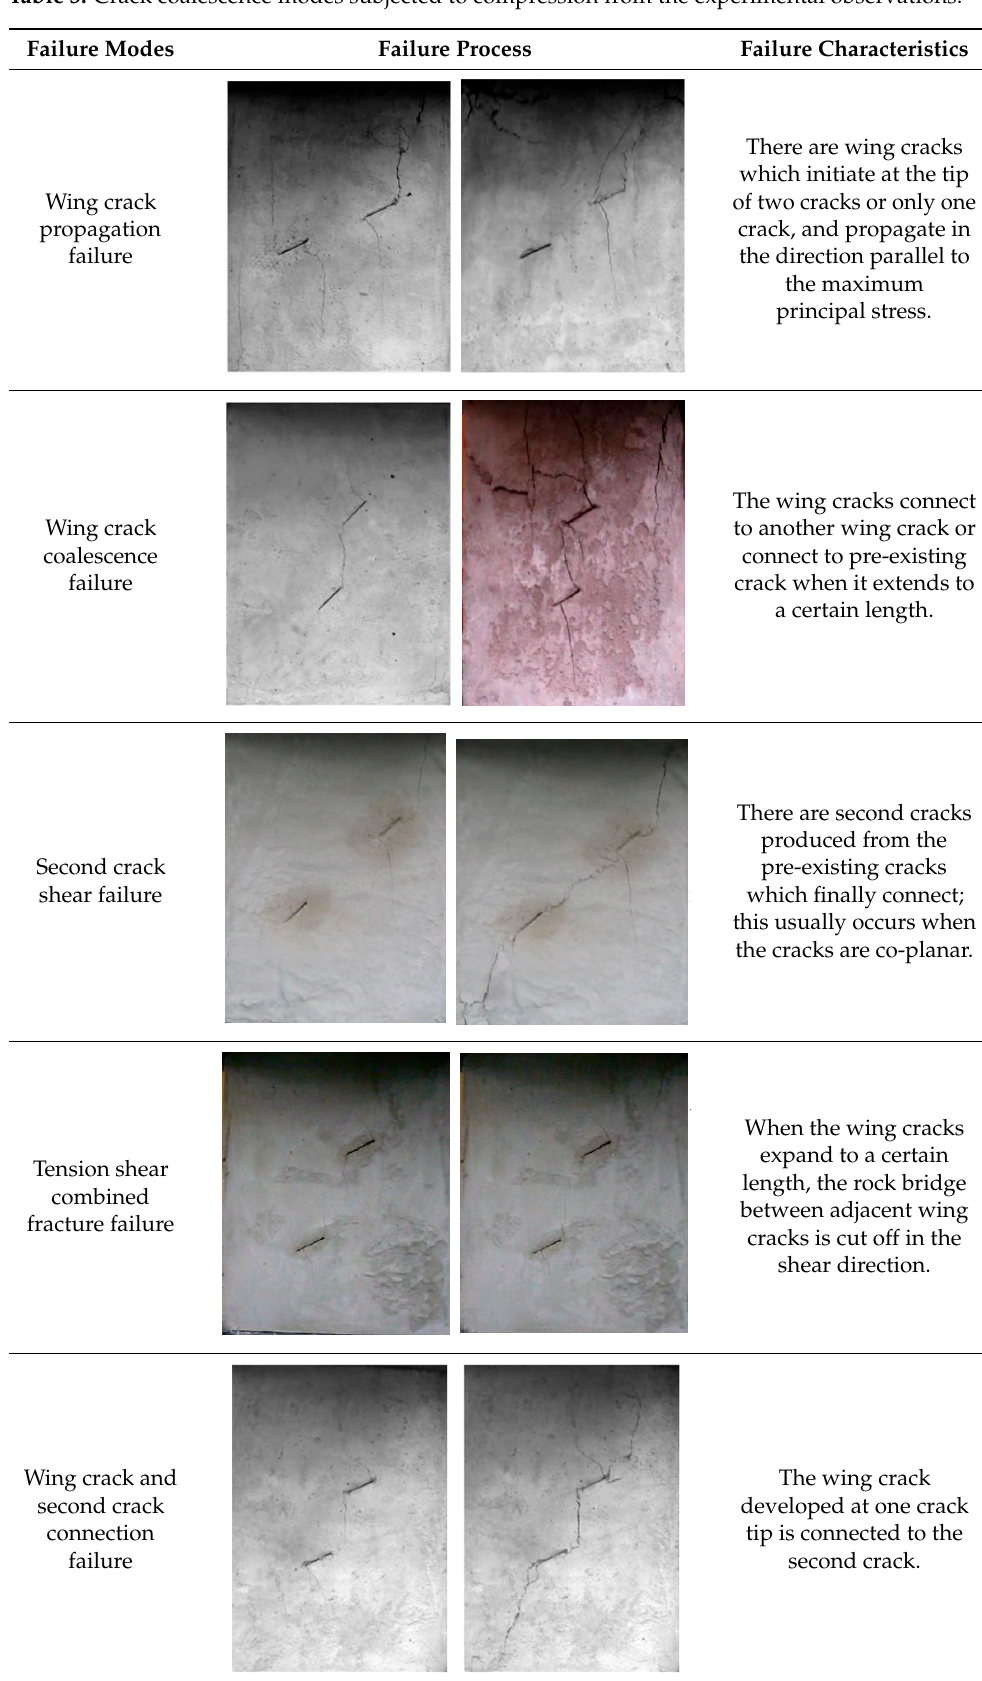
Table 3. Crack coalescence modes subjected to compression from the experimental observations.